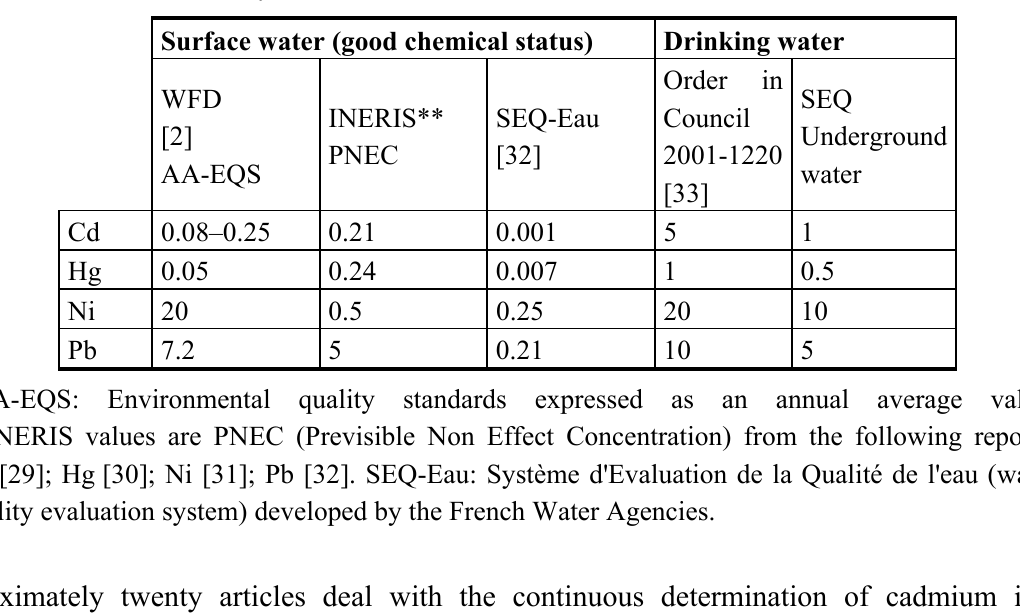
Table 1. Summary of the superior limit concentrations (µg/L) of metallic elements, recommended or statutory in fresh water.